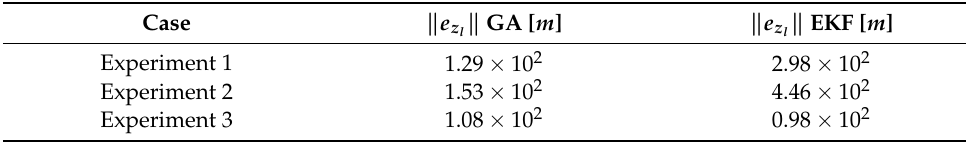
Figure 13. Experiment 2: leak induced in valve two: ( a ) Pressure head and flow rate at upstream, ( b ) Output residuals, ( c ) Flow rate at downstream nodes and, ( d ) Leak position. Table 2. Error norm for each LDI